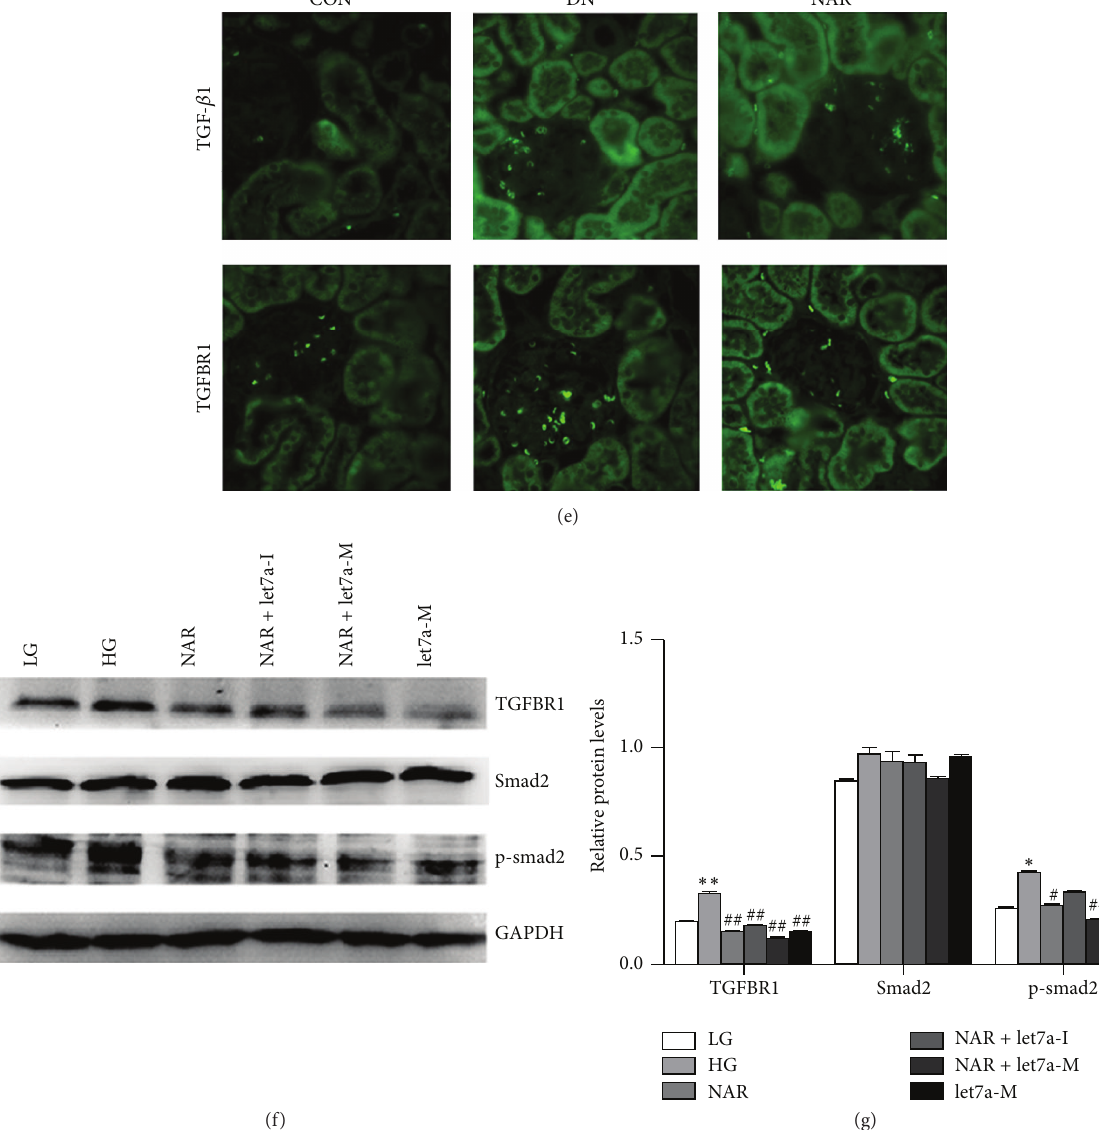
Figure 5: NAR inhibited TGF- 𝛽 1/smads signaling through let-7a in vivo and in vitro. (a) Real-time RT PCR showed the mRNA levels of TGF- 𝛽 1, TGFBR1, smad2, and smad7 of kidney tissues in rats. (b) Western blot analysis of TGF- 𝛽 1, TGFBR1, smad2, p-smad2, and smad7 proteins in kidney tissues and MMCs. (c) Quantifications of the western blot bands of TGF- 𝛽 1, TGFBR1, smad7, and p-smad2 expressions in DN rats. (d) Quantifications of the western blot bands of TGF- 𝛽 1, TGFBR1, smad7, and p-smad2 expressions in MMCs. (e) Immunofluorescence of TGF- 𝛽 1 and TGFBR1 proteins in kidney tissues of rats. (f) Western blot analysis of TGFBR1, smad2, and p-smad2 proteins in MMCs transferring let-7a mimics or inhibitor with NAR. (g) Quantifications of the western blot bands of TGFBR1 and p-smad2 expressions in MMCs transferring let-7a mimics or inhibitor with NAR. (a) Results were normalized with GAPDH and expressed as mean ± standard deviation ( 𝑛 = 4 per group). ∗ 𝑝 < 0.05 ; ∗∗ 𝑝 < 0.05 versus CON group; # 𝑝 < 0.05 ; ## 𝑝 < 0.01 versus DN group. (c) Results were normalized with GAPDH and expressed as mean ± standard deviation ( 𝑛 = 3 per group). ∗∗ 𝑝 < 0.01 versus CON group; # 𝑝 < 0.05 ; ## 𝑝 < 0.01 versus DN group. (d) Results were normalized with GAPDH and expressed as mean ± standard deviation ( 𝑛 = 3 per group). ∗ 𝑝 < 0.05 ; ∗∗ 𝑝 < 0.01 versus LG group; # 𝑝 < 0.05 ; ## 𝑝 < 0.01 versus HG group. (g) Results were normalized with GAPDH and expressed as mean ± standard deviation ( 𝑛 = 3 per group). ∗ 𝑝 < 0.05 ; ∗∗ 𝑝 < 0.01 versus LG group; # 𝑝 < 0.05 ; ## 𝑝 < 0.01 versus HG